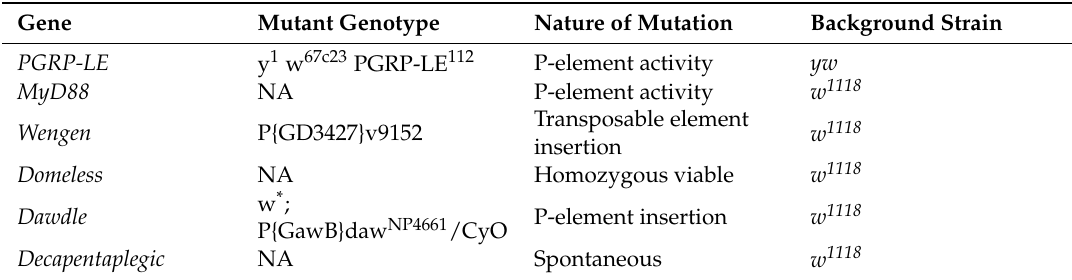
Table A1. Drosophila melanogaster strains used in this study.